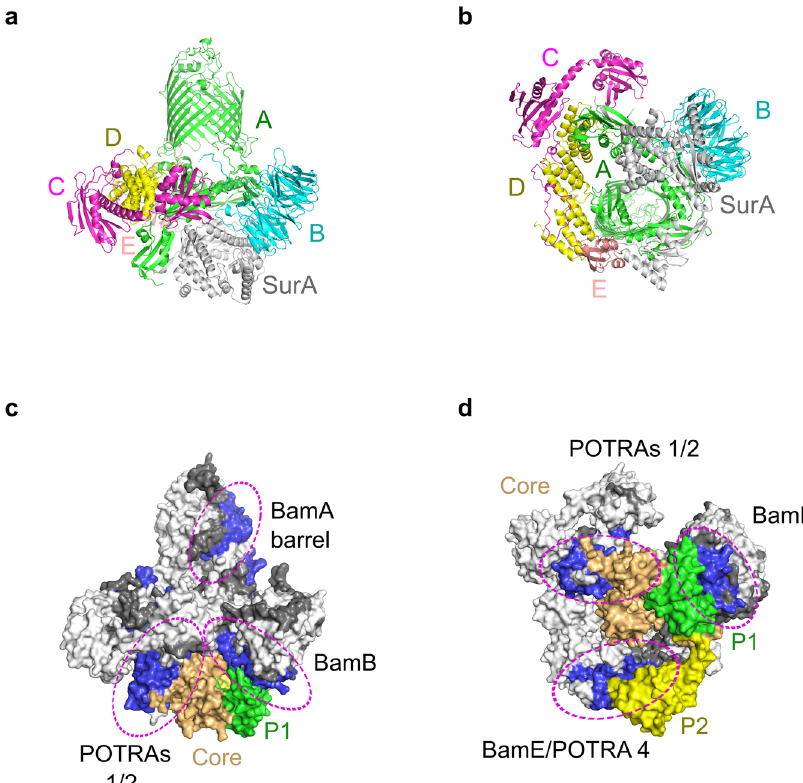
Fig. 5 AlphaFold-Multimer generated model of the BAM – SurA complex. a , b The predicted structure of the BAM – SurA complex coloured by subunit. SurA is in grey. c , d Surface views of the BAM – SurA complex with regions of HDX protection in the BAM complex upon binding SurA highlighted, and SurA coloured by domain. Regions of BAM that are protected from HDX in the presence of SurA are highlighted in blue. Regions in white show no change in deuterium uptake in the presence of SurA, while those in dark grey denote sequences for which peptides were not detected. Patches of protection from HDX upon SurA binding in the BamA β -barrel domain (adjacent to the lateral gate), POTRAs 1 and 2, BamB, and BamE/POTRA 4 are ringed in magenta. The SurA core, P1 and P2 domains are coloured in orange, green and yellow, respectively. Left panels show a side view of the complex, and right panels a view from the periplasmic